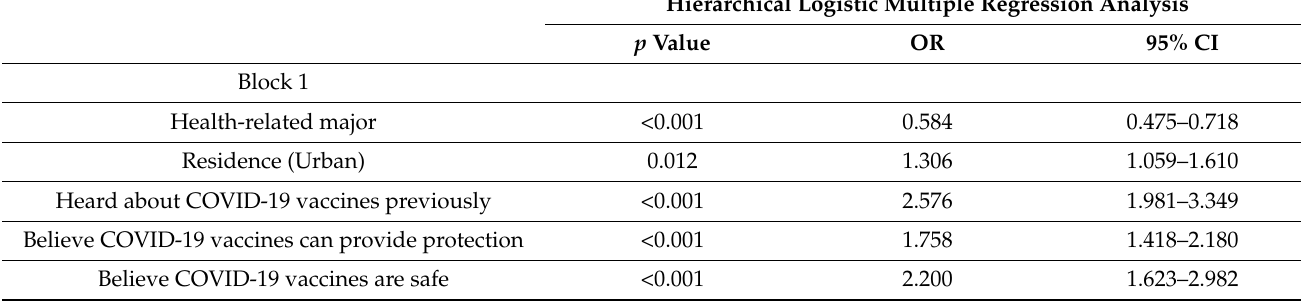
Table 2. Hierarchical logistic multiple regression model of factors that were associated with willingness to receive a COVID-19 vaccine in the